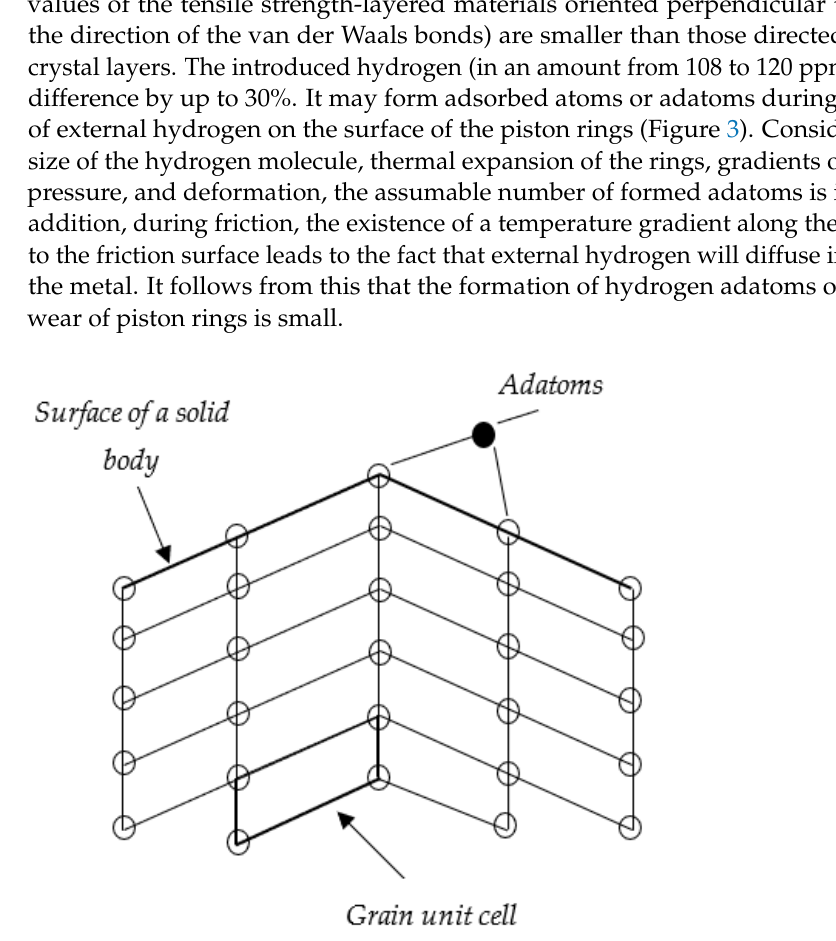
Figure 3. Formation of hydrogen adatoms at the crystal lattice boundary.